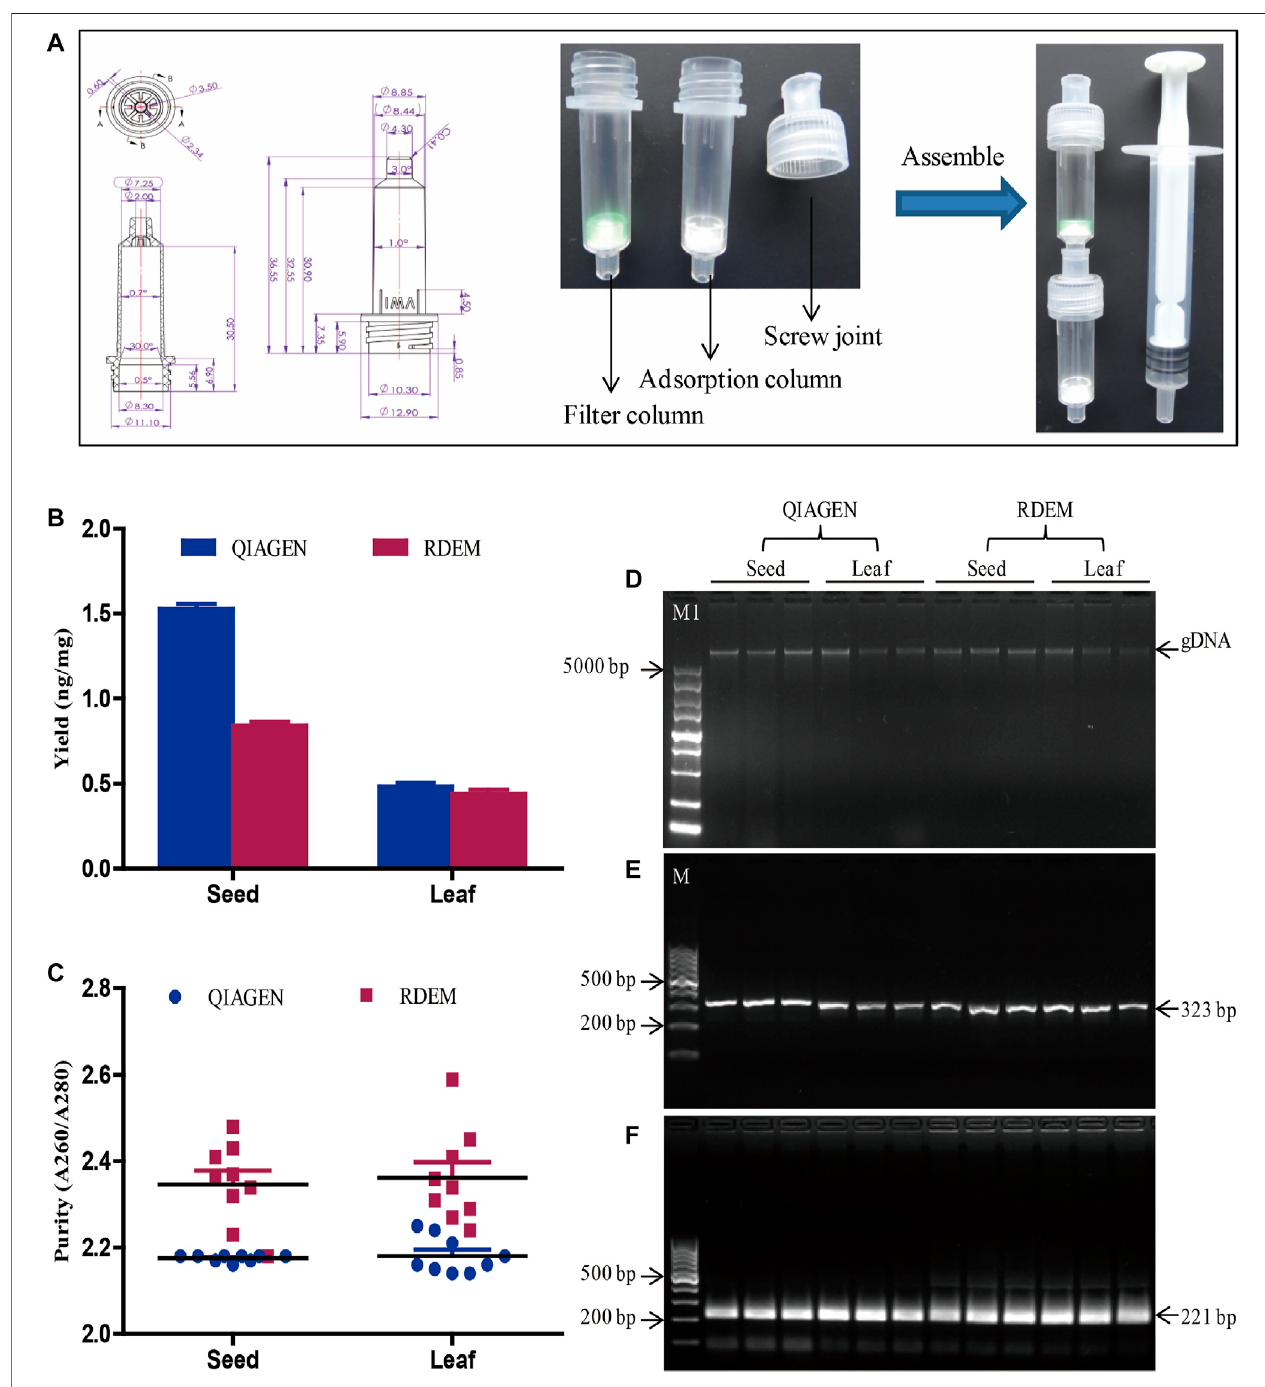
FIGURE 1 | DNA extraction and evaluation. (A) Diagram of the RDEM. (B) Comparison of DNA yields of the QIAGEN kit and RDEM. (C) Comparison of DNA purity of the QIAGEN kit and RDEM. (D) Agarose gel electrophoresis of the extracted genomic DNA from the seed and leaf using the QIAGEN kit and RDEM. (E) Conventional PCR ampli fi cation ofthe 18SrRNA gene from all the extracts. (F) Basic RPA ampli fi cation of 18S rRNA gene from all the extracts. M1: DL5000 DNA marker, M: DL1000 DNA marker.